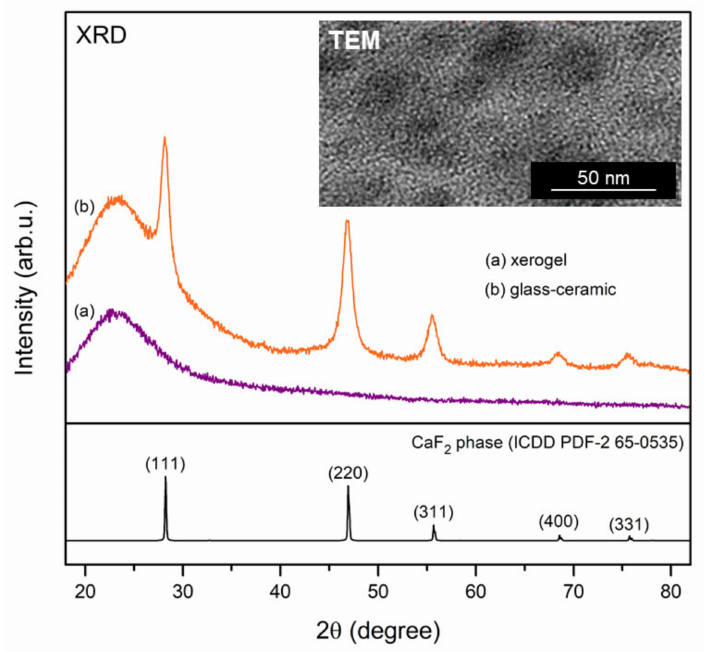
Figure 1. XRD patterns of XG 1Tb1Eu and GC 1Tb1Eu co-doped sol-gel materials. Inset shows the TEM image of glass-ceramic fabricated at 350 ◦ C.